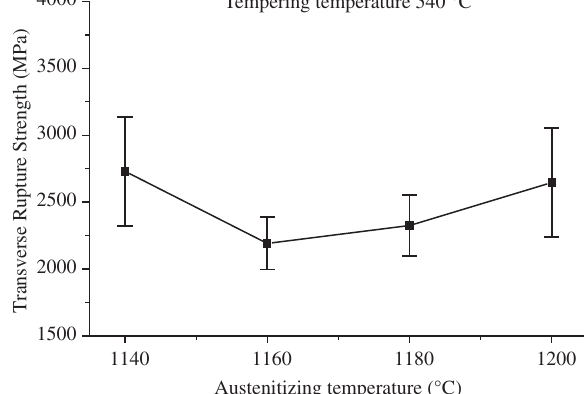
Figure 9. TRS as a function of austenitizing temperature (tempered at 540 °C).